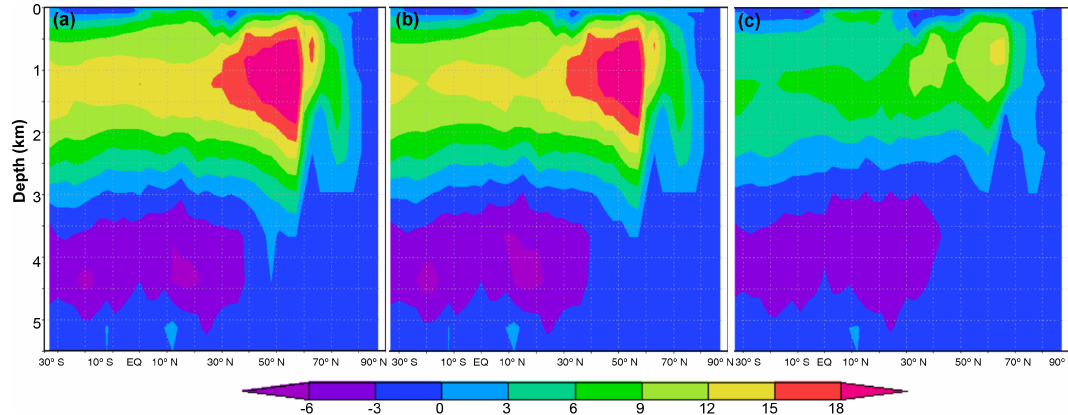
Figure 12. Meridional overturning stream function (Sv) in the Atlantic Ocean basin. Panels (a) , (b) and (c) indicate the control run (PI) and the simulations OG11.5 and OGIS11.5, respectively. On the left-hand side, depth is indicated in kilometers. Positive values indicate a clockwise circulation. Maximum AMOC strength value was 22Sv (reached at about 1200m depth) in the PI and OGIS simulation, while it was only about 14Sv (reached at 600–700m depth) in OGIS11.5.